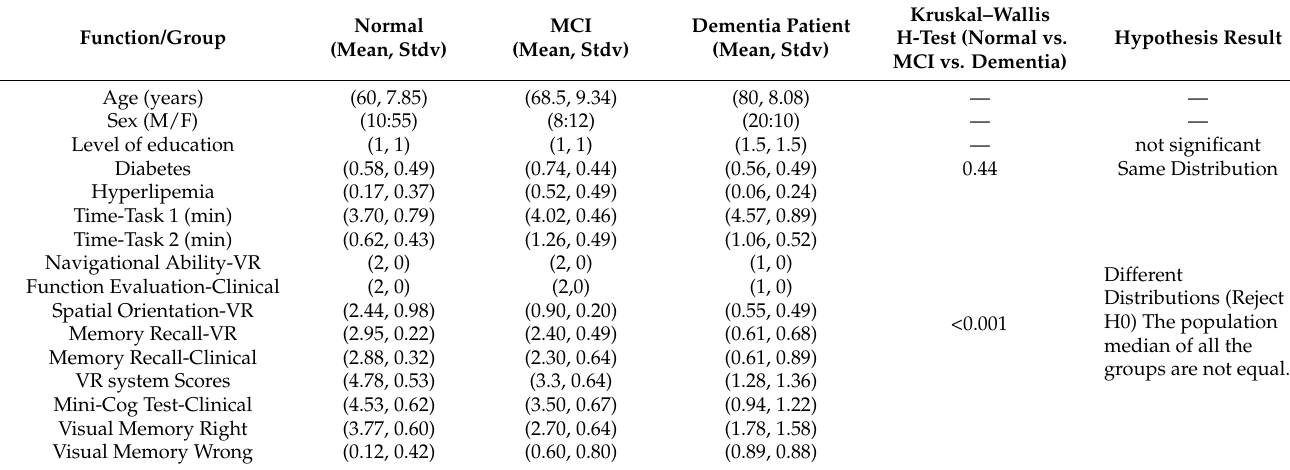
Table 2. Kruskal–Wallis H-Test, means, and SDs of demographics and general neuropsychological abilities and VR system. Function/Group